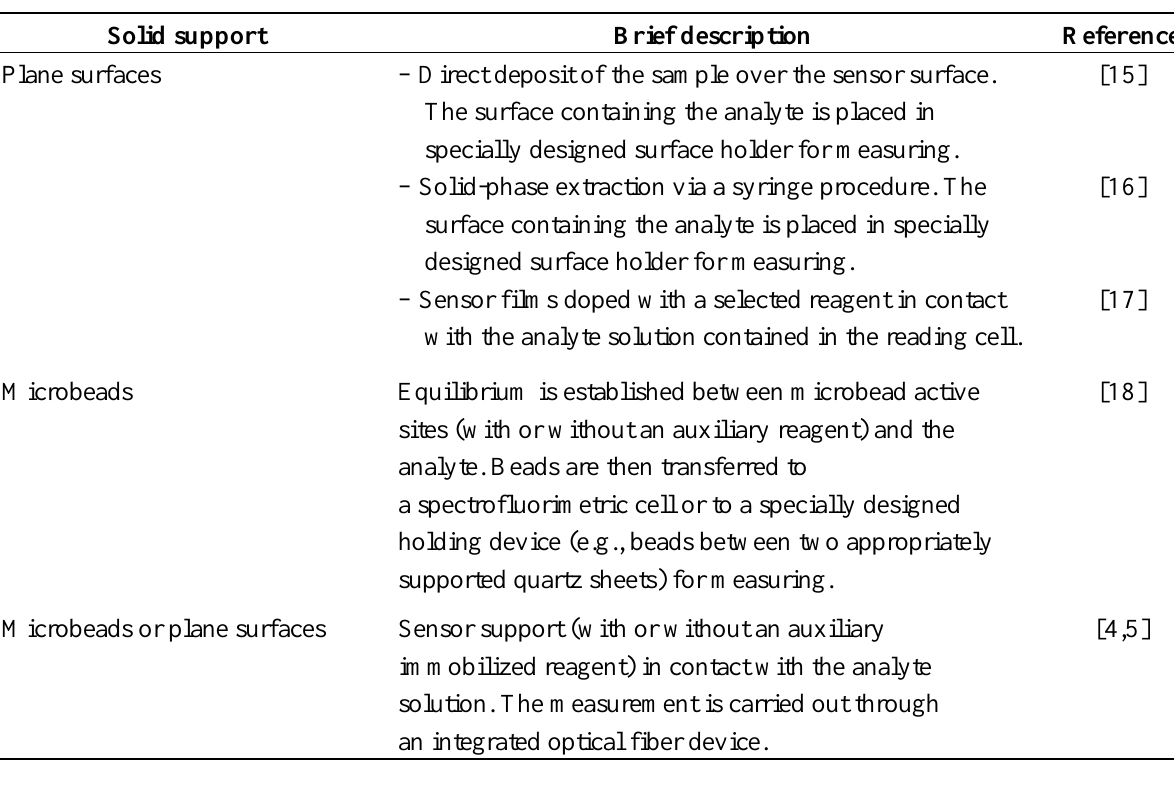
Table 1. Techniques used for performing luminescence probe